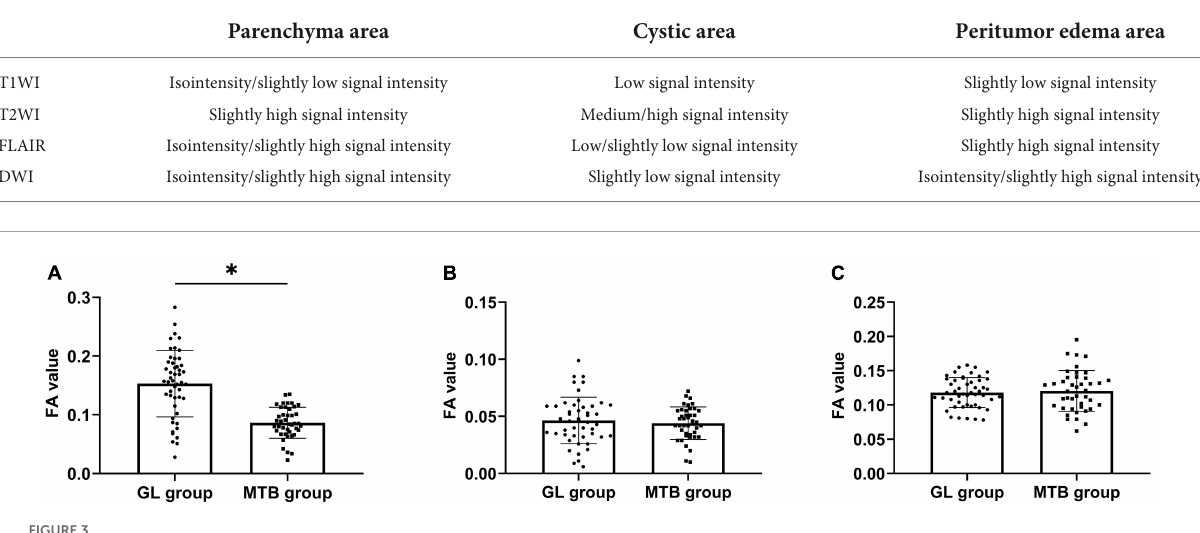
TABLE 3 MRI findings of MTB.